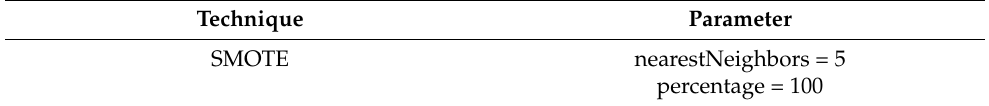
Table 3. Summary of the parameters used for the imbalance approach.